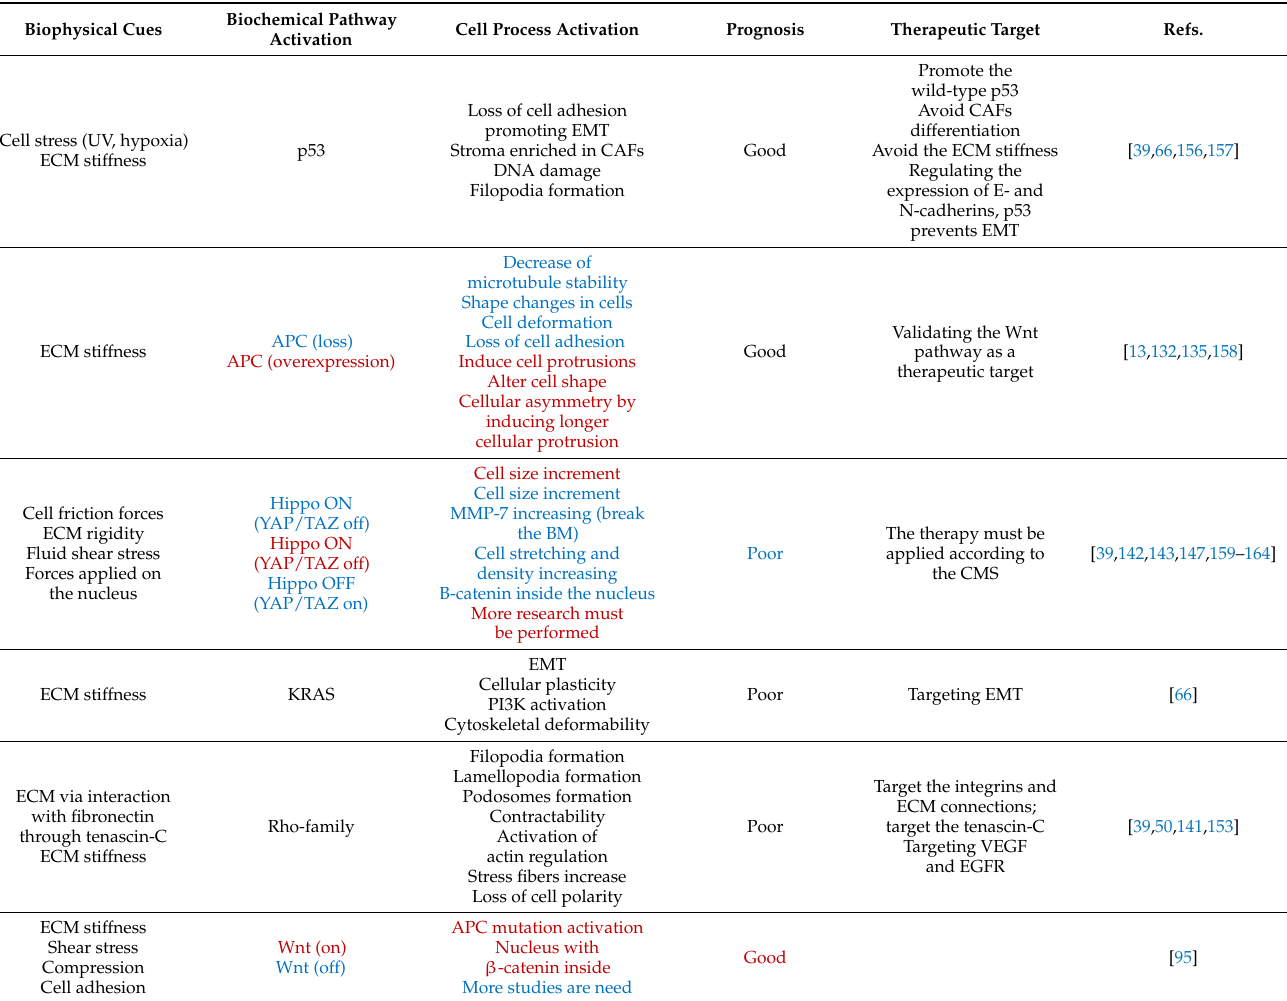
Table 2. Biophysical cues and its relation with biochemical pathways, their influence on CRC behavior, prognosis, and possible therapeutic